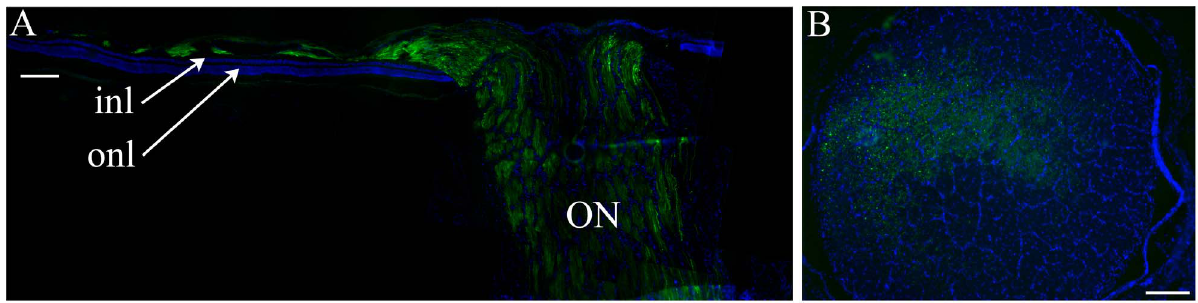
Figure 2. A. Low power retinal section from eye 8-OD through the optic nerve (ON). Green shows GFP expression and blue is DAPI staining. Note that there is GFP expression in axons within the optic nerve and also within the part of the inner retina corresponding to the nerve fiber layer. The section is taken through the dorsal vasculature radiating from the optic nerve head and the blood vessels are the reason that the nerve fiber layer is not a continuous layer in this section. This region is away from the subretinal injection bleb which is why only the nerve fiber layer is expressing GFP and the outer retina is not. Inl=inner nuclear layer; onl=outer nuclear layer. Size bar 100 m m. B. Section through the optic nerve from eye 2-OD. This eye received an injection of AAV2(quadY-F). Green is GFP expression, blue DAPI staining. GFP expression is seen in the axons of the optic nerve. Size bar 250 m m.